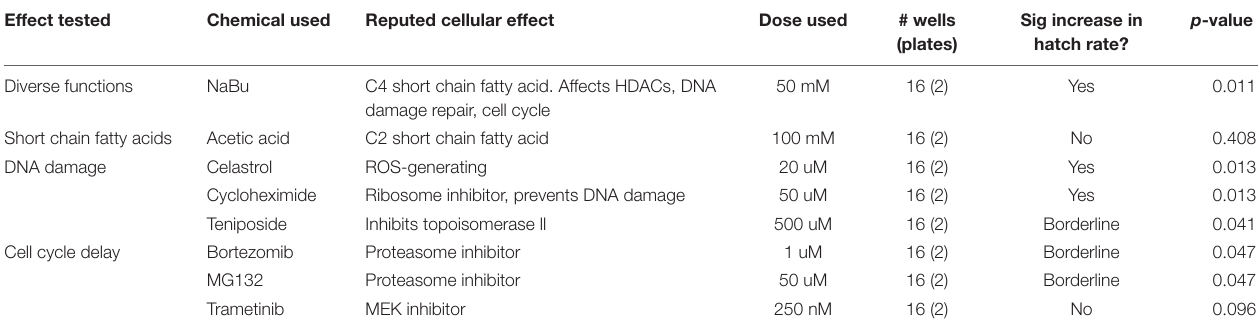
TABLE 4 | Impact of chemical treatments on CI egg hatch rates for w Mel-infected D. simulans. Effect